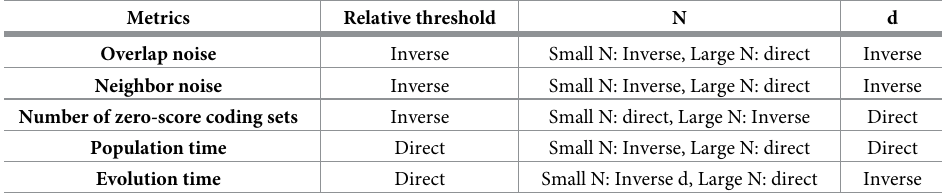
Table 1. Effectiveness of optimizing triple parameters (i.e. relative threshold, E, and N) and coding metrics.